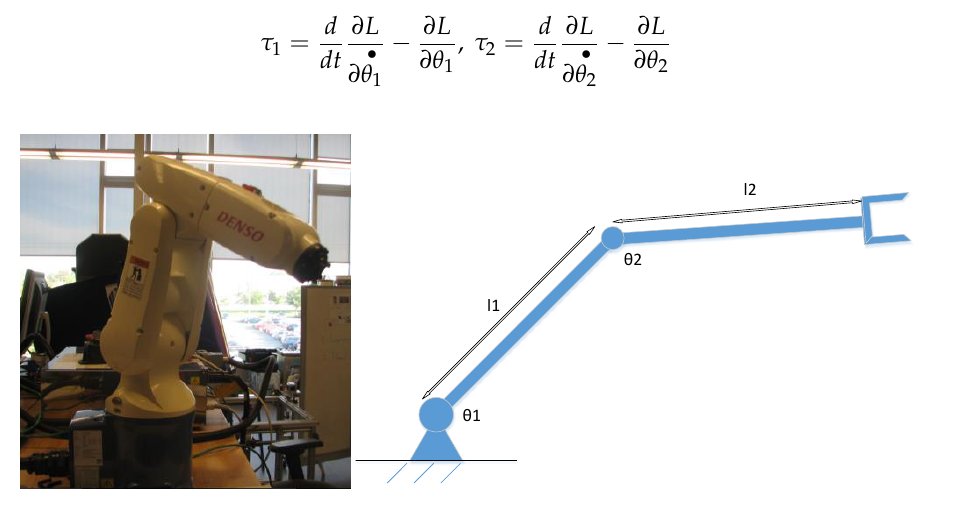
Figure 1. Two-link manipulator .